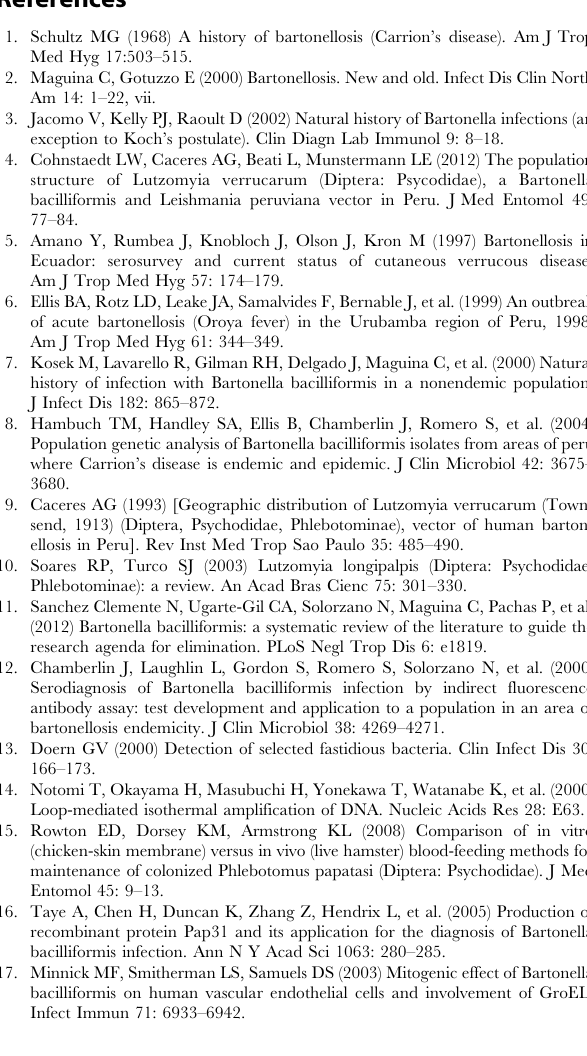
S1 Figure Flow diagram of a diagnostic accuracy in detection of pap31 in sand flies post feeding on blood infected with B. bacilliformis by LAMP compared to